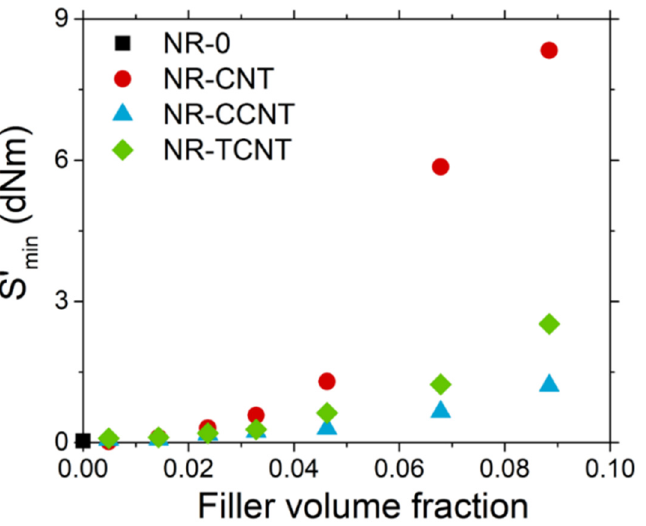
Figure 10. Variation of the minimum torque, S' min with the filler volume fraction for NR/CNTs, NR/CCNTs, and NR/TCNTs.